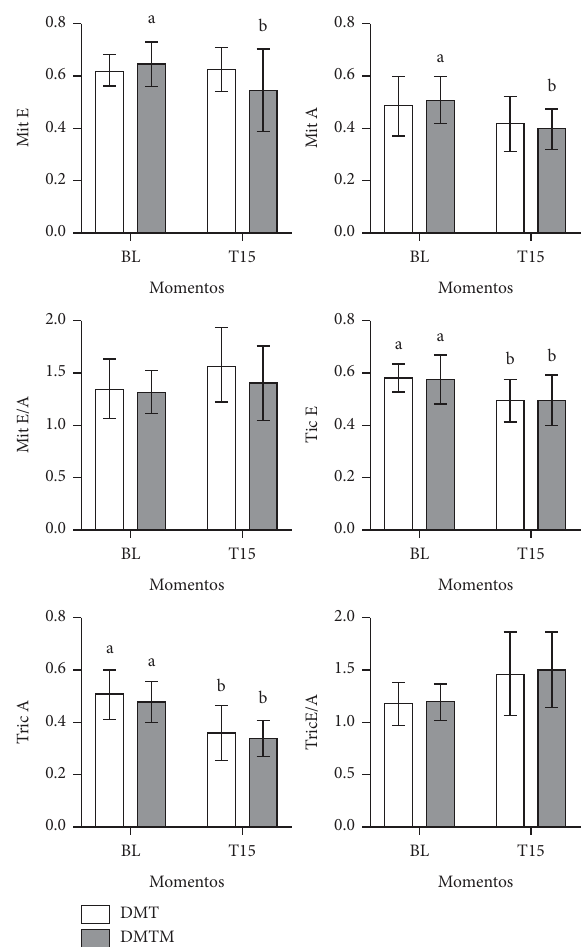
Figure 5: Values of E wave (E) and A wave (A) in the mitral valve, ratio of the E/A wave in the mitral (Mit E/A), E wave (tric (E)), and A wave (tricus (A)) in the tricuspid valve, and tricuspid E/A wave ratio (tric E/A) in 18 cats sedated with the combination of dex- medetomidine (7.5ug/kg) and methadone (0.3mg/kg) (DMT, n � 9) or dexmedetomidine (5ug/kg), methadone (0.3mg/kg), and midazolam (0.3mg/kg) (DMTM, n � 9), both by intramuscular route. Values are presented as mean ± standard deviation. a, b: diferent lowercase letters indicate a signifcant diference between moments within the same group according to the Tukey test ( p < 0 .